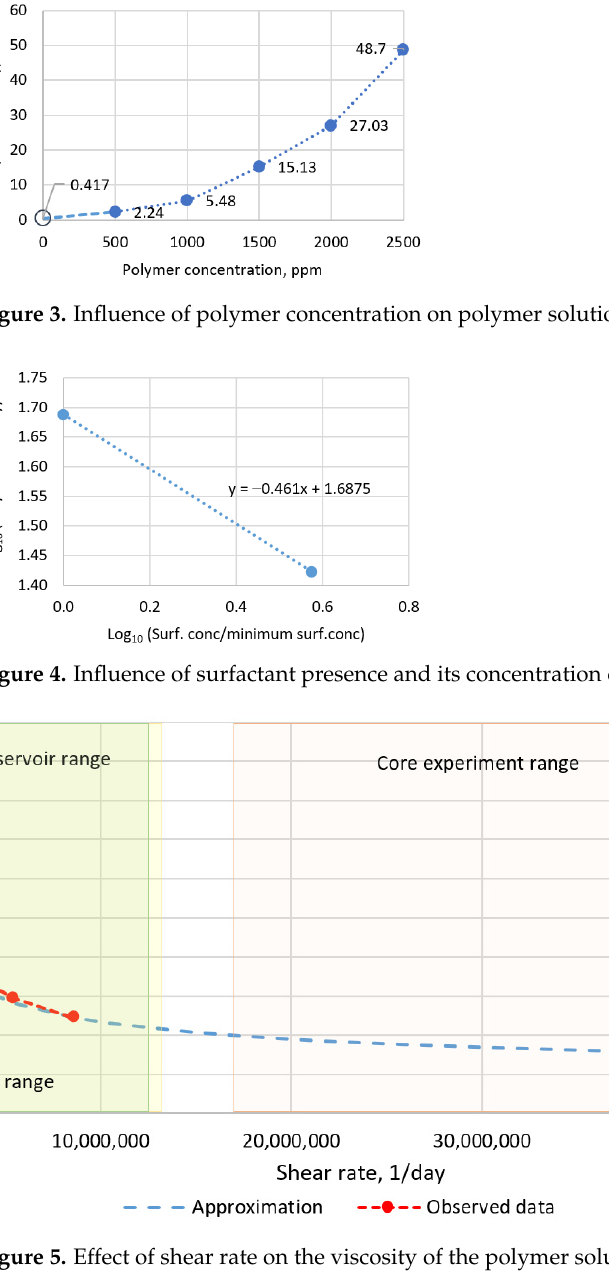
Figure 6. Dependence of interfacial tension on surfactant concentration. One of the steps in tuning the polymer and surfactant adsorption parameters on the rock was scaling the static adsorption data by the adsorption obtained from the filtration experiment. The adsorption concentration dependence curves determined by the static method were used as a starting point for the data, and then the adsorption curve obtained by the parallel transfer method was normalized to the experimental dynamic adsorption point, after which the curves were further smoothed. This process is necessary, since for a correct description of adsorption behavior it is necessary to perform a large number of experiments for different concentrations of chemical agents, which in practice turns out to be a very expensive process and requires a considerable amount of time. In this case, only dynamic adsorption gives a real picture of the retention on the surfactant rock and polymer in the reservoir (Figures 7 and 8).